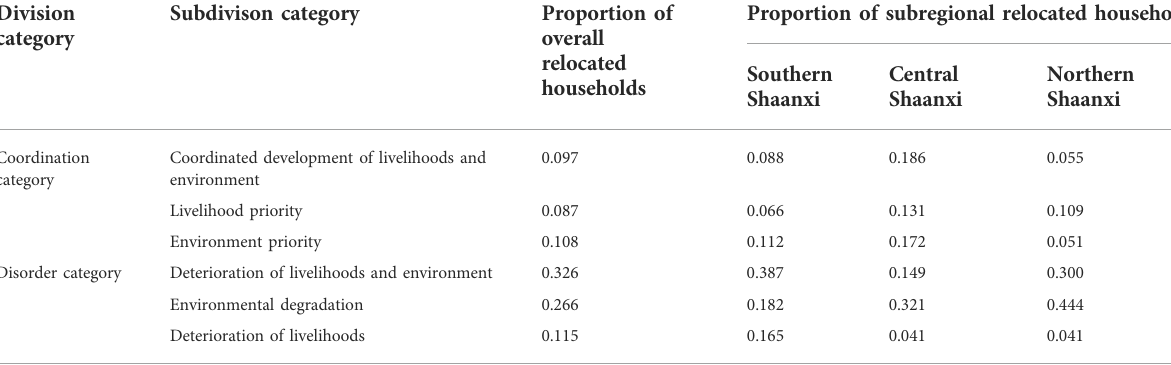
TABLE 7 Proportions of the overall and regional relocated households in comparison categories of “ livelihoods – environment ” links. Division